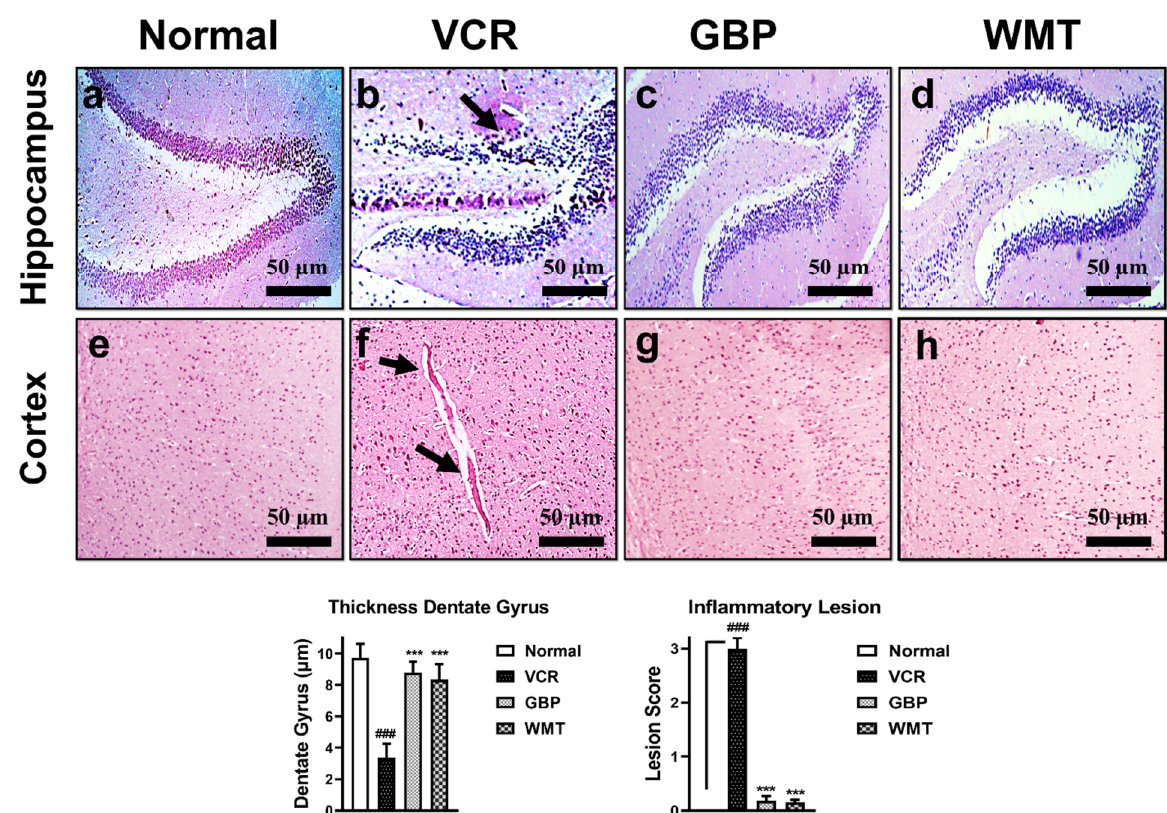
Figure 8. Effect of withametelin on the histopathological changes in the brain (hippocampus and cortex) (H&E; 10×). Representative photomicrographs of the dentate gyrus of the hippocampus. Normal ( a ), VCR ( b ), GBP ( c ), and WMT ( d ). WMT and GBP suppressed the reduction in the granular layer of the hippocampal dentate gyrus. The black arrowhead shows a reduction in the hippocampal dentate gyrus. Representative photomicrographs of the cortex. Normal ( e ), VCR ( f ), GBP ( g ), and WMT ( h ). The WMT treatment significantly reduced the neuropathology associated with VCR (inflammatory plaque formation in the cerebral cortex). The black arrowhead shows inflammatory plaque in the cortex. All results were expressed as the mean ( n = 3) ± SD. ### p < 0.001 compared to the normal control group; *** p < 0.001 compared to the VCR group.